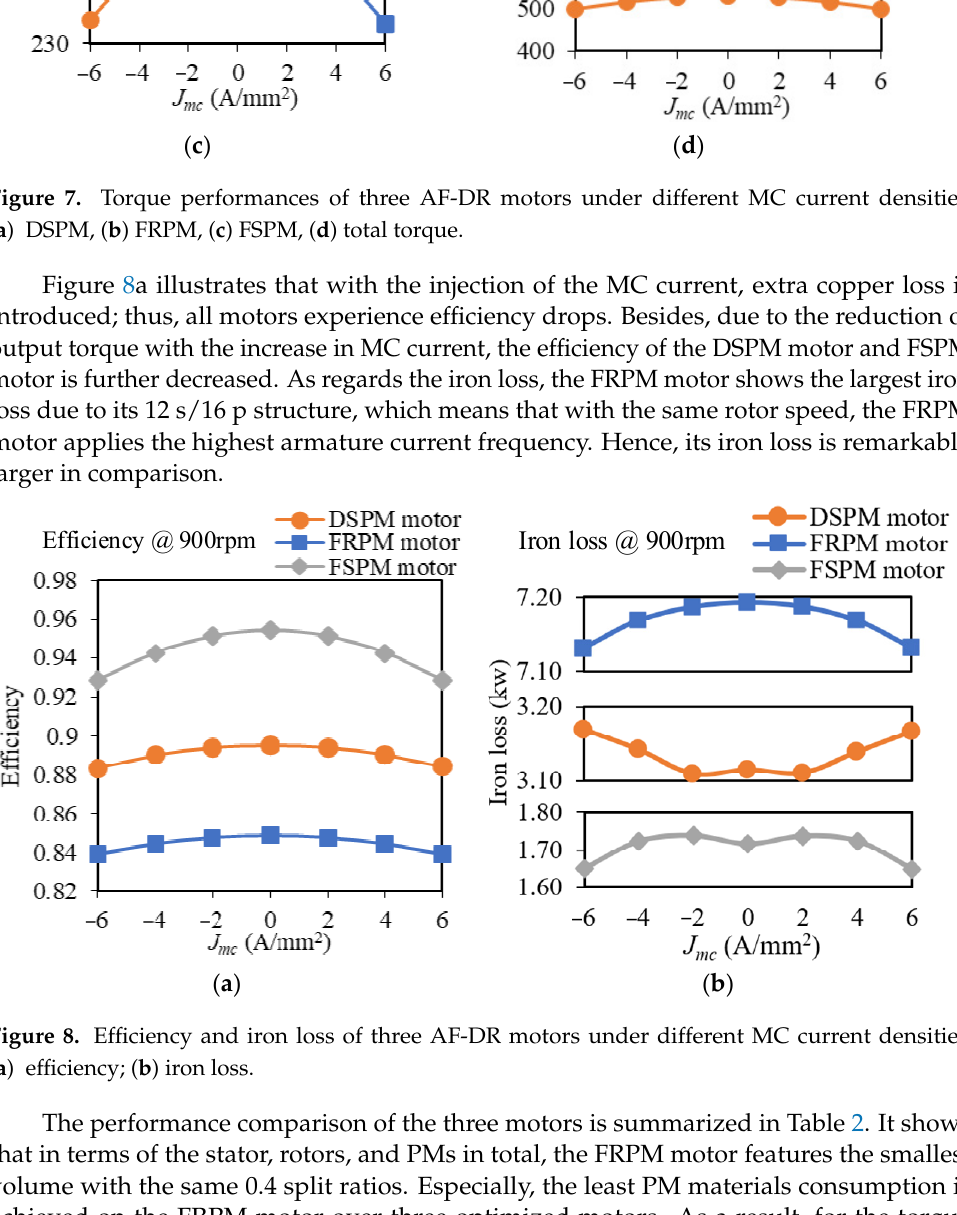
Figure 8. Efficiency and iron loss of three AF-DR motors under different MC current densities: ( a ) efficiency; ( b ) iron loss.